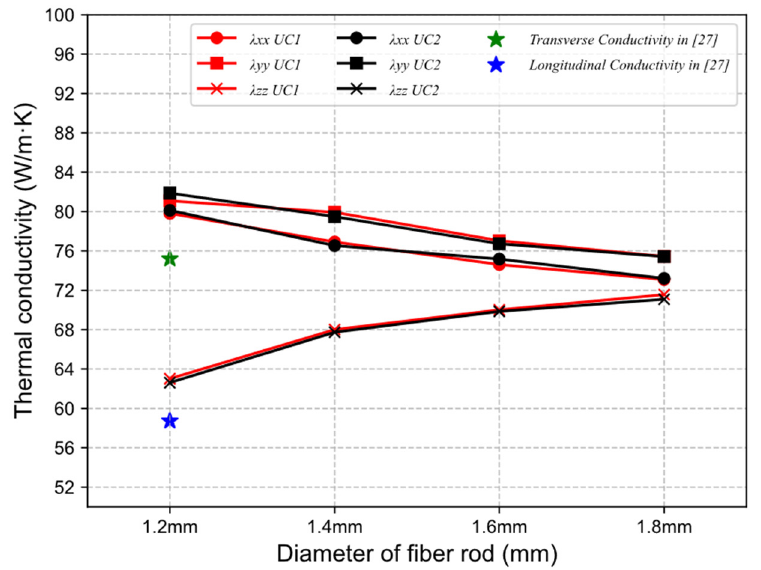
Figure 15. The effective thermal conductivities of UC1 and UC2 with carbon fiber rods of different diameters.